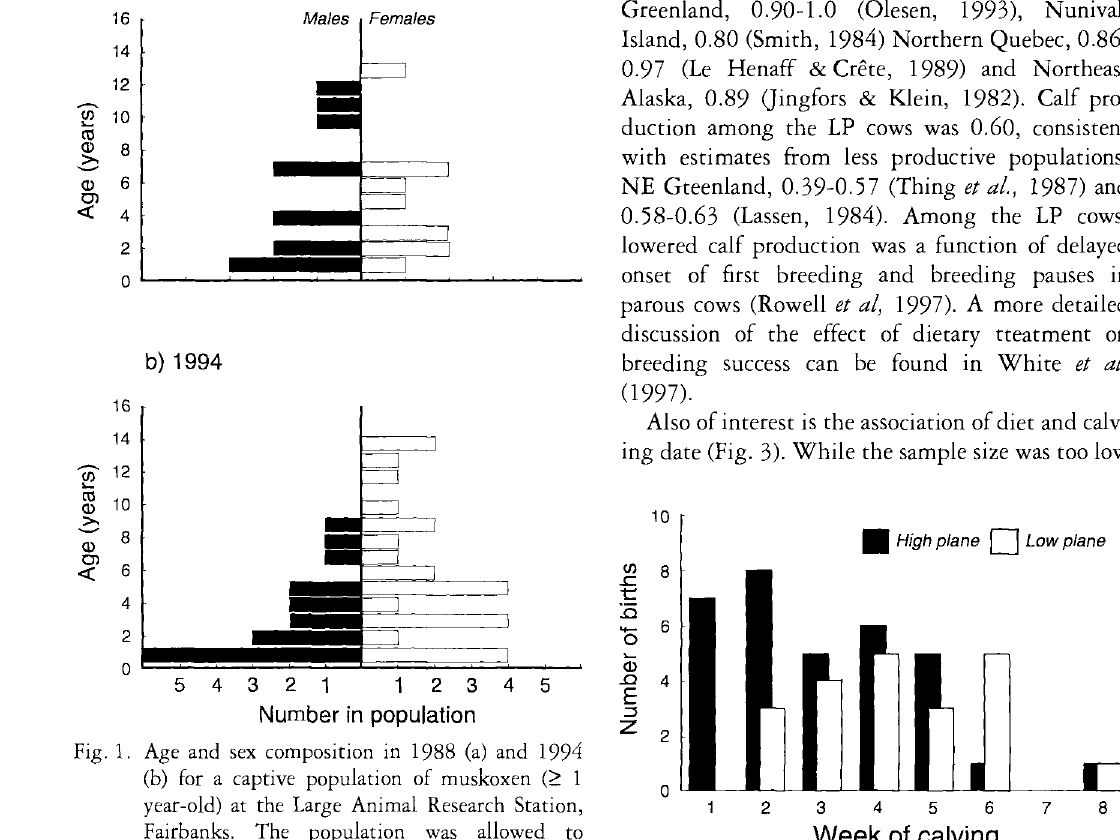
Number in population Fig. 1. Age and sex composition in 1988 (a) and 1994 (b) for a captive population of muskoxen (> 1 year-old) at the Large Animal Research Station, Fairbanks. The population was allowed to increase from 22 individuals in 1988 to 43 Fig. 3- Maternal plane of nutrition and timing of calving individuals in 1994. among captive muskoxen, 1988-1994. Week